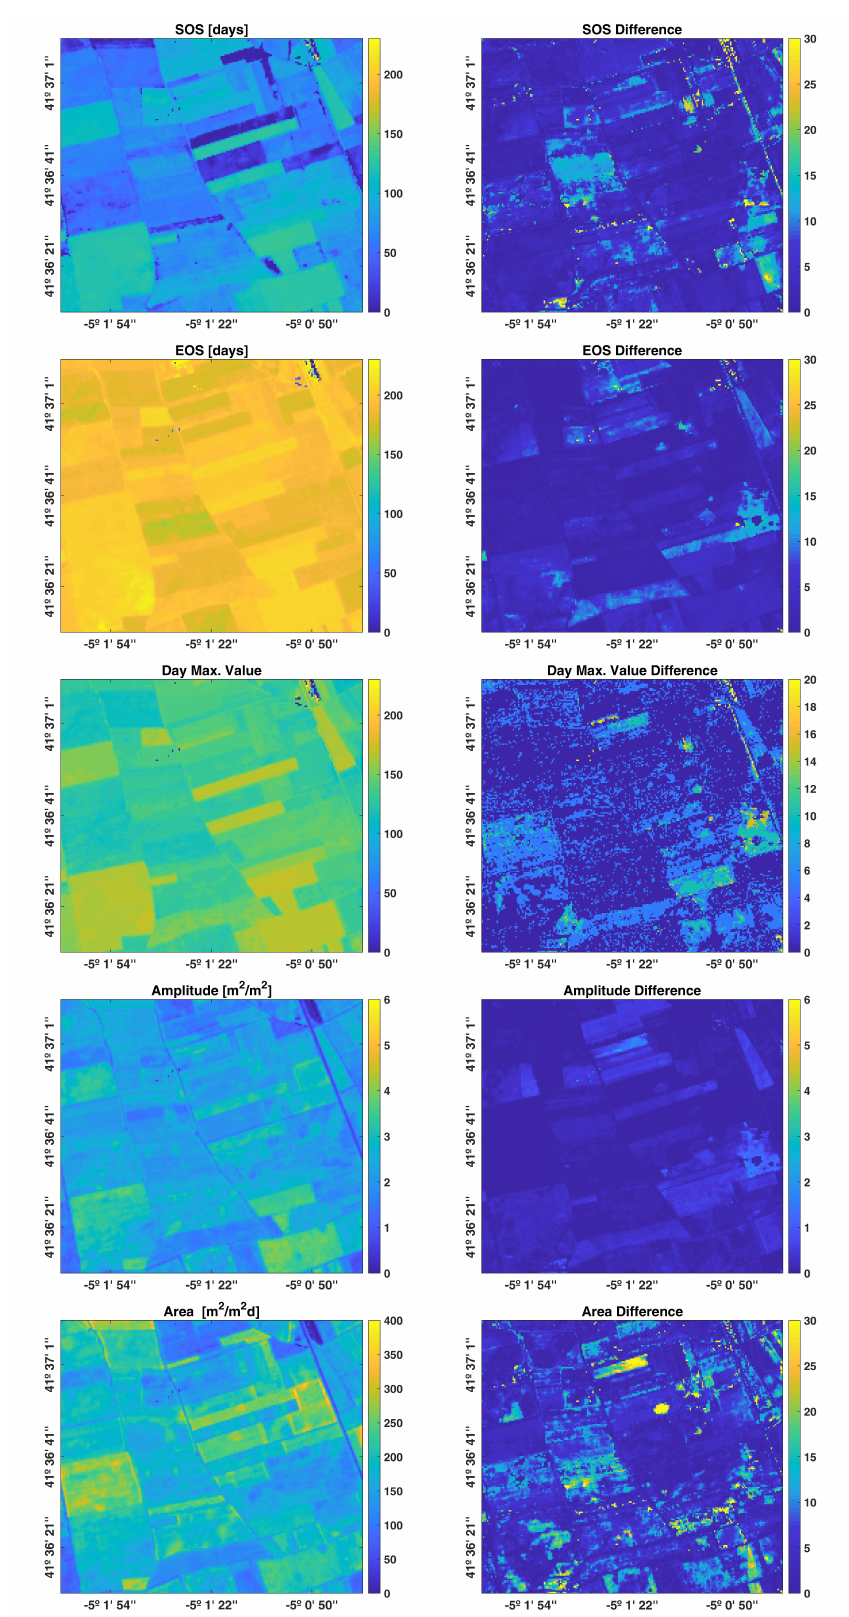
Figure 4. Phenological indicator maps estimated by using θ gl ( left column) and their differences regarding θ pp ( right column). Counting of days starts from 1 January